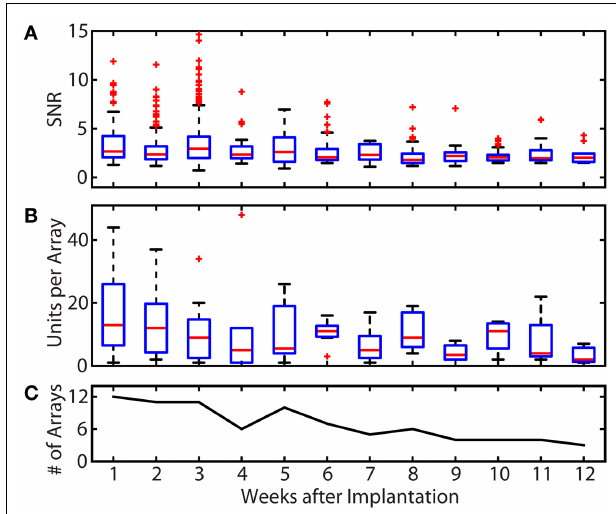
FIGURE 3 | Summary of recording quality and quantity for the duration of all implants . (A) Summary of the SNR of all units over time. The median SNR (shown by the red line) remained at 2 or higher over the lifetime of all implants. Some single unit recordings with very high SNR values were observed in the first 4weeks post-implantation. (B) Summary of motor unit yields over time. Single unit yield was calculated using units with an SNR >1.2.The mean number of units per array was 17.3 in week 1 and remained between 10.5 and 13.5 through week 6.The total single unit yield decayed over the implant periods, resulting in a mean of 3.3 units per array at week 12. (C) Number of arrays recorded from per week. Because the total implant time in each animal and the number of recording session per week varied, only available arrays were included in unit yield and SNR calculations.These variations explain the increases in yield between weeks 5 and 6 (and other weeks), which reflects the elimination of failed implants from the pool of arrays being evaluated. In the boxplots of (A,B) , the red line represents the median values, the upper and lower limits of the boxes represent the 75th and 25th percentiles, and the whiskers extend to cover approximately 99.3% of the data. Red “ + ” signs are data that fall outside of this range and are considered